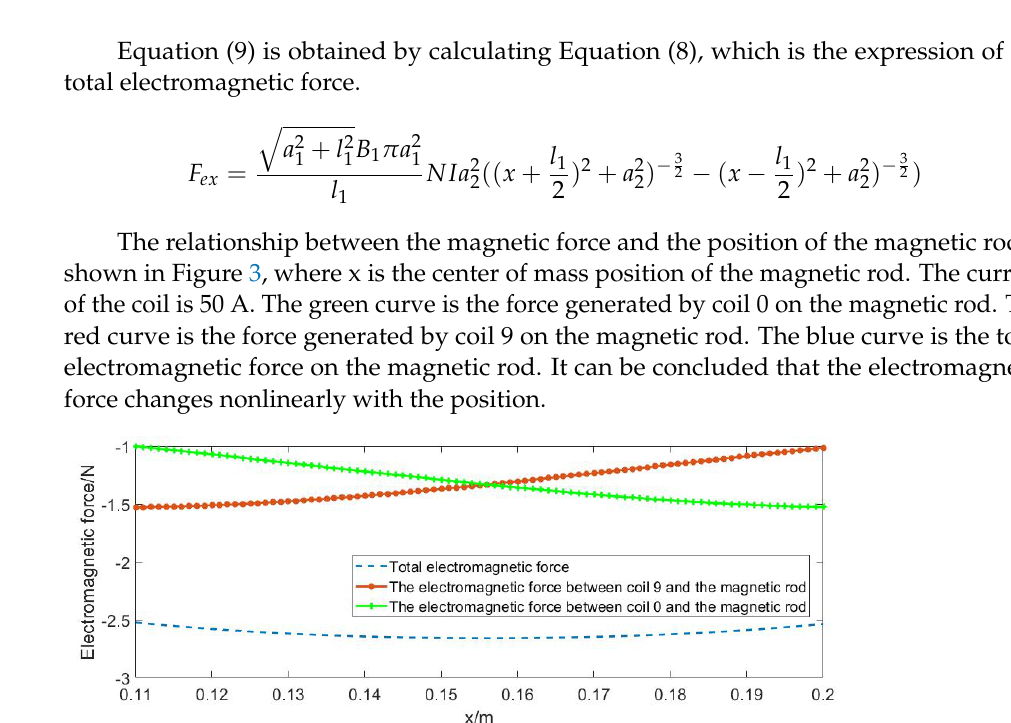
Figure 3. Characteristic diagram of the x-direction electromagnetic